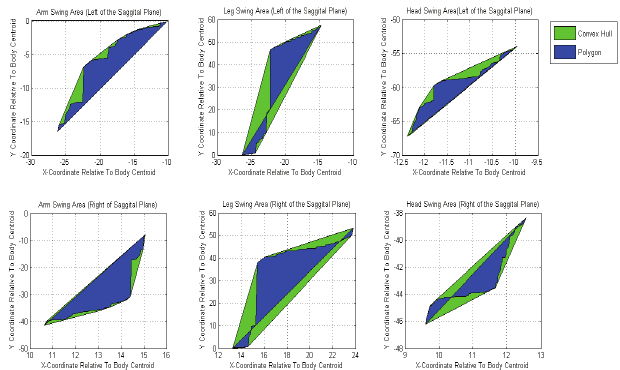
Fig.6. Illustration of feature points using polygon and convex hull shape for 2km/hr. gait